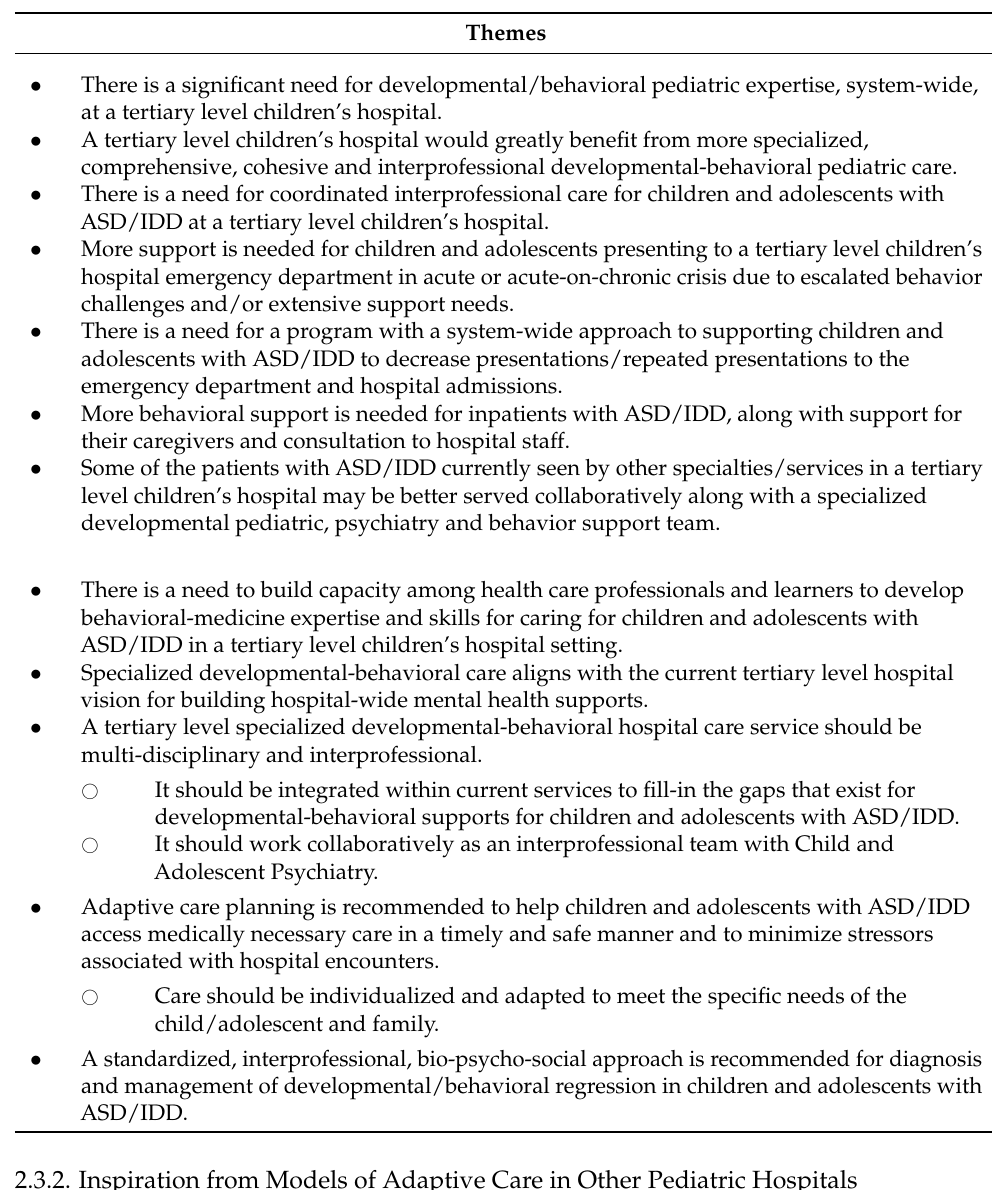
Table 2. Stakeholder perspectives on tertiary level hospital care needs for children and adolescents with